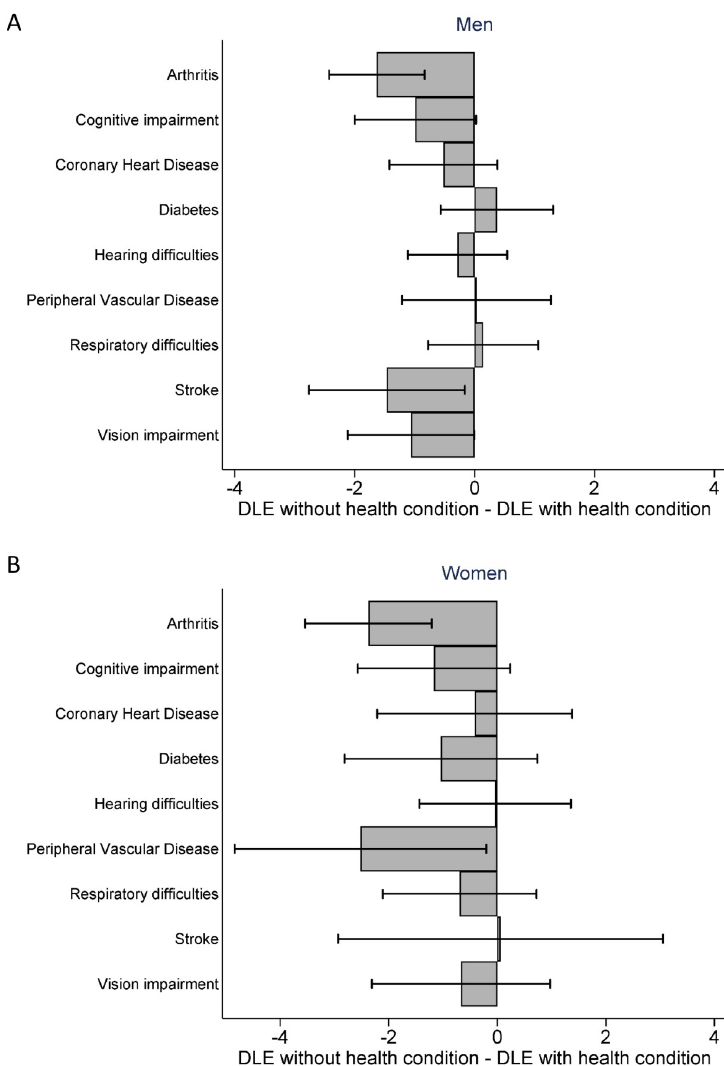
Fig 3. Difference in years with disability (DLE) between men (A) and women (B) with and without the health condition (DLE without health condition–DLE with health condition) in CFAS II with 95% CIs. Models stratified by sex and study and adjusted for age and health condition. Results also shown in Tables C and E in S5 Text with 95% CIs and p -values. CFAS, Cognitive Function and Ageing Studies; CI, confidence interval; DLE, life expectancy with